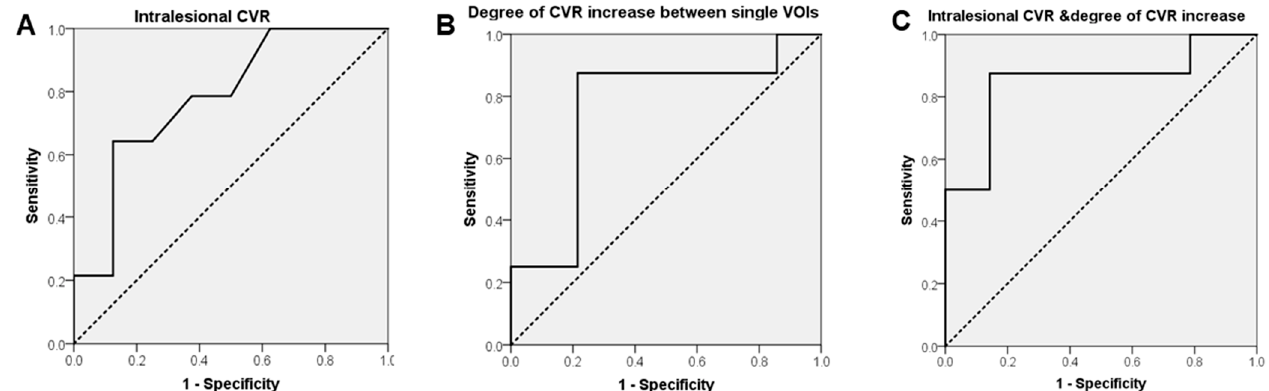
Figure 3. Receiver Operating Characteristic curve for BOLD-CVR in the contrast-enhancing lesion, CVR changing rate, and for the combination of the two parameters. ( A ) Area under the curve (AUC) of CVR in the contrast-enhancing part of the lesion (AUC: 0.78, 95% CI: 0.57–0.99); diagonal segments are produced by ties. ( B ) AUC of the CVR changing rate in the analyzed VOIs (AUC: 0.76, 95% CI: 0.53–0.99. ( C ) Intralesional CVR and CVR increase rate throughout the expanding VOIs were analyzed together by performing a binary logistic regression and obtaining probability estimates (AUC: 0.85, 95% CI: